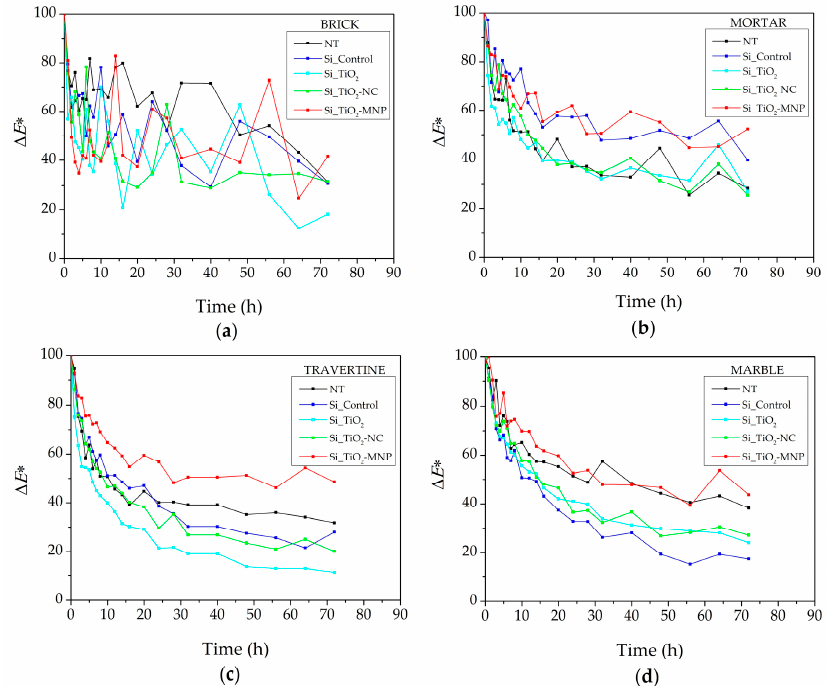
Figure 5. Evolution of total color difference ( ∆ E *) for samples irradiated under UV light (365 nm) in laboratory conditions: ( a ) brick, ( b ) mortar, ( c ) travertine, and ( d ) Carrara marble. NT: untreated; Si_Control: coating without nanoparticles; Si_TiO 2 : coating with TiO 2 nanoparticles; Si_TiO 2 -NC: coating with TiO 2 nanoparticles and loaded silica nanocapsules; Si_TiO 2 -MNP: coating with TiO 2 nanoparticles and loaded silica mesoporous nanoparticles.